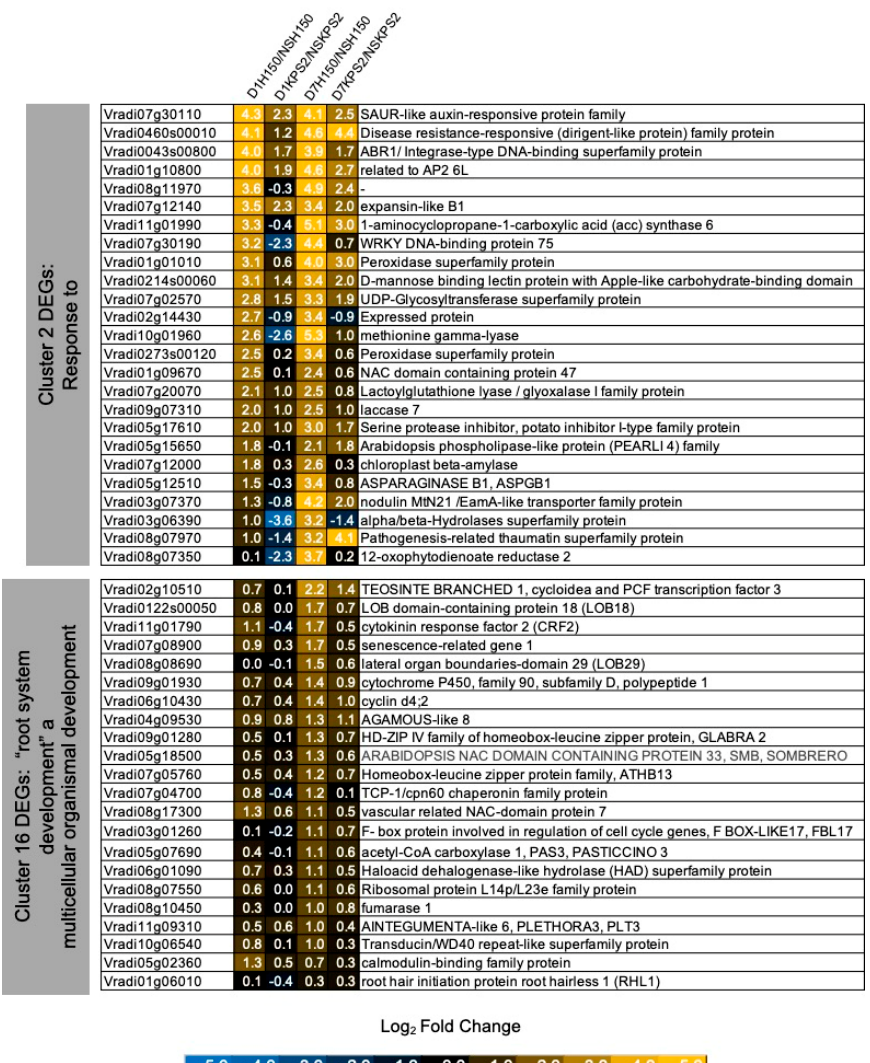
Figure 8. Differential expression of DEGs involves in regulation of stress response and development. Expression pattern of selected DEGs from cluster 2 (transcription regulators) and cluster 16 (multicellular organismal development and Leucine-rich kinases). Data can be found in Table S2.